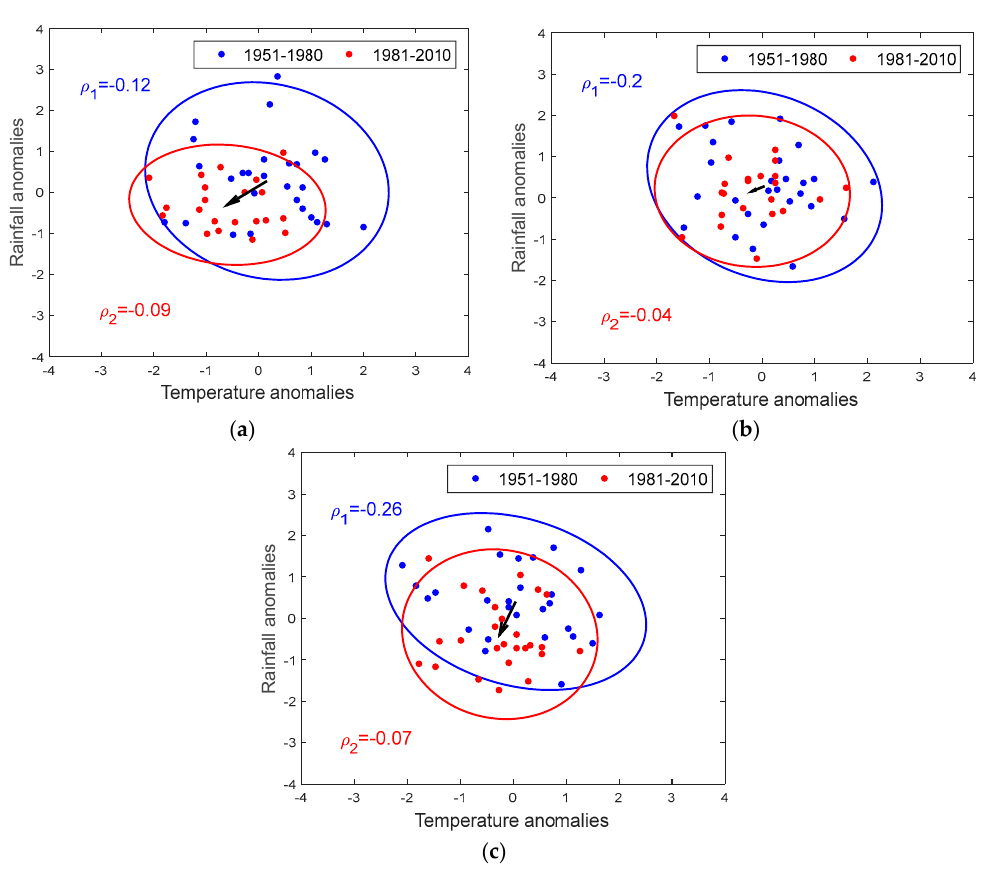
Figure 4. The 95% confidence ellipses for the autumn season at gauge ( a ) 930; ( b ) 1010; ( c ) 1180. Table 5. Testing results of the change in the means of the seasonal values of temperature ( T ) and rainfall ( R ) observed in 1951–1980 and 1981–2010. ( H , Hotelling’s test; t ( T ) and t ( R ), two-sample t -test. Statistically significant results at the 95% confidence level are in bold italics.)